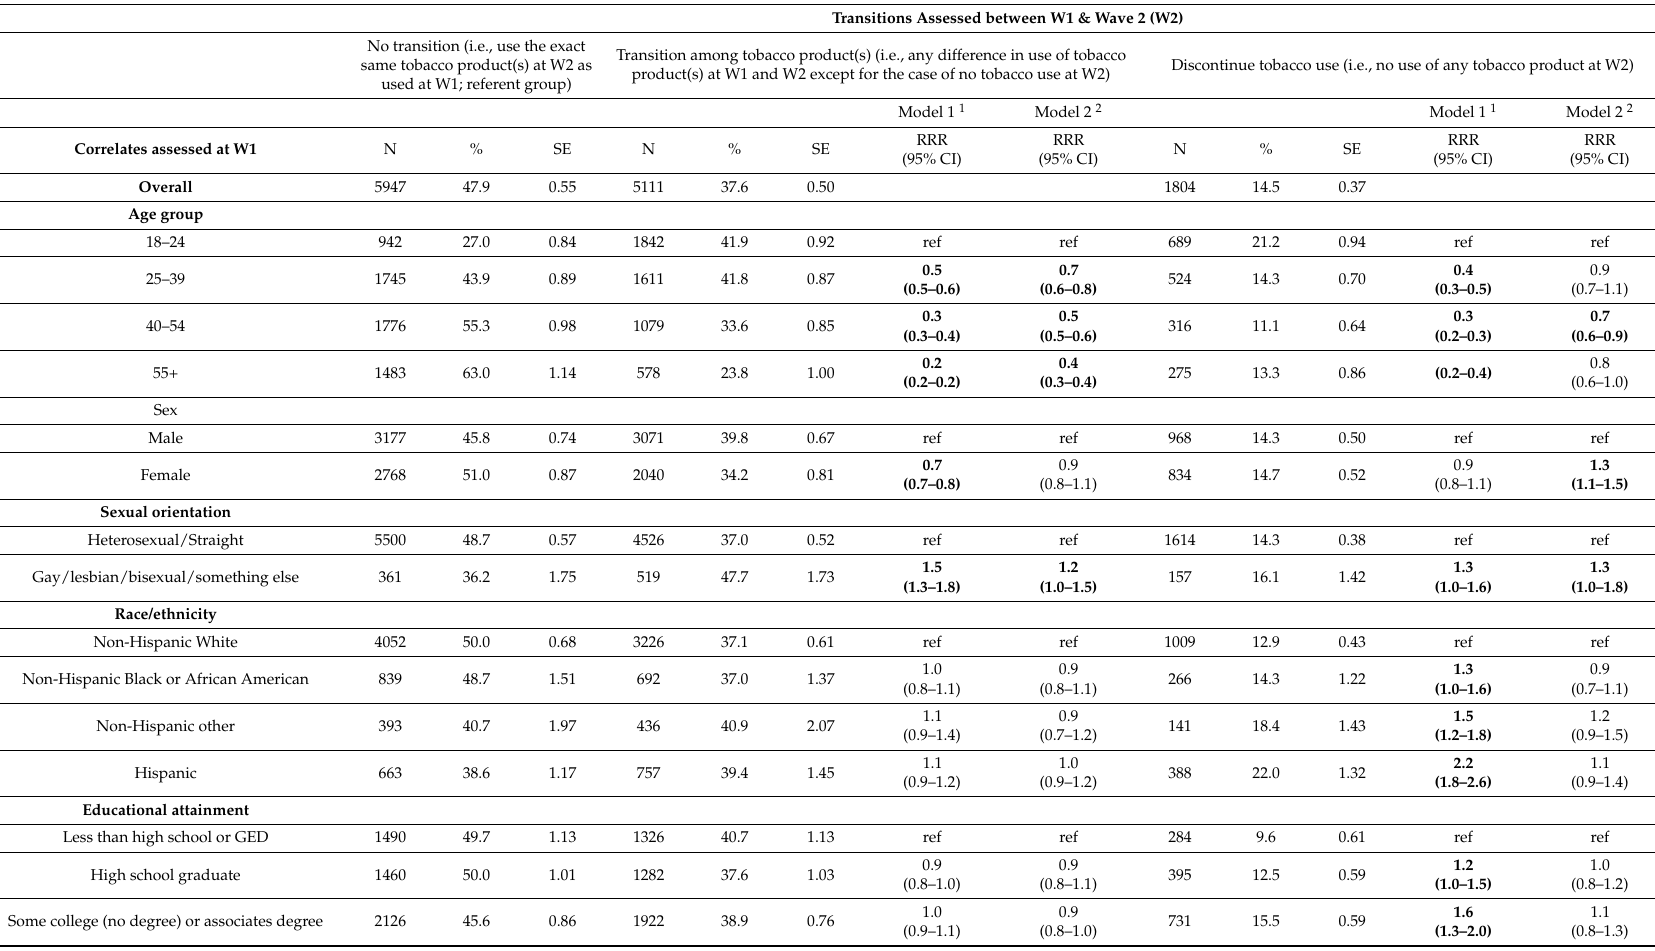
Table 1. Correlates of transitions in tobacco product use among ‘any tobacco’ users at Wave 1 (W1) of the Population Assessment of Tobacco and Health (PATH) Study